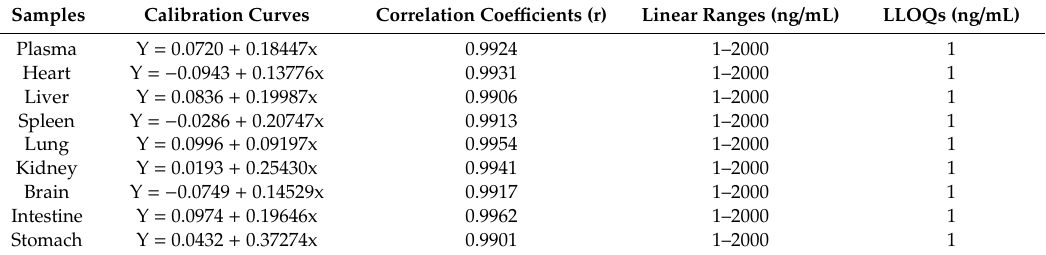
Table 2. Standard curves and LLOQ of gardneramine in biological samples.